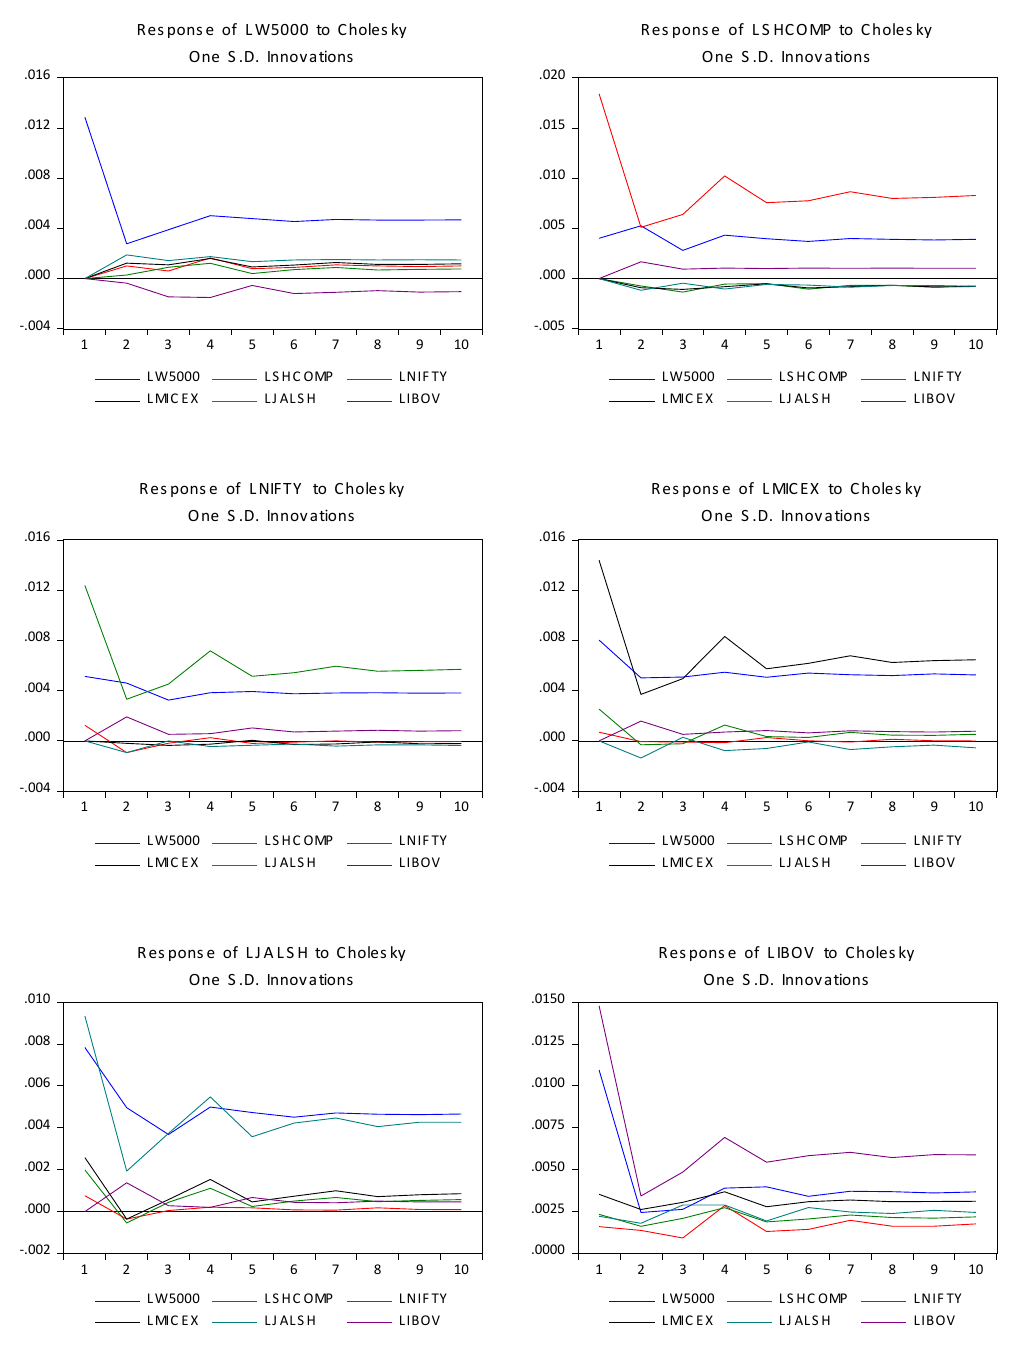
Figure 2. Impulse response function